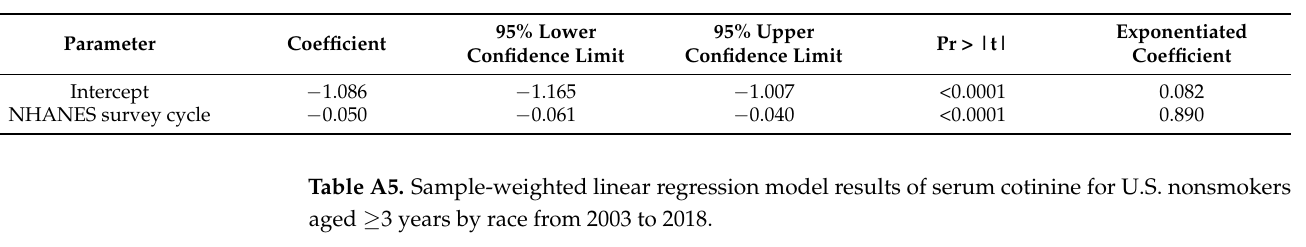
Table A4. Sample-weighted linear regression model results of serum cotinine for U.S. nonsmokers aged ≥ 3 years from 2003 to 2018.